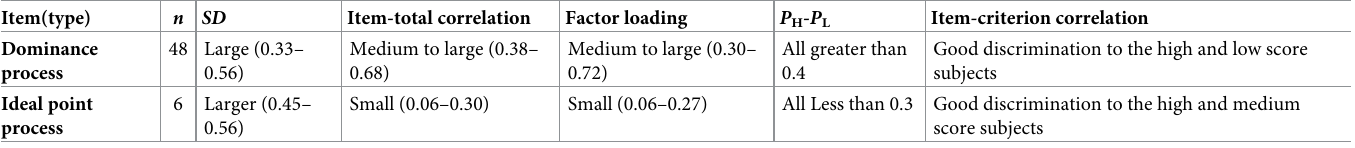
Table 1. The final 54 items of OCD-trait screening scale after multiple selections (initially 80 items).